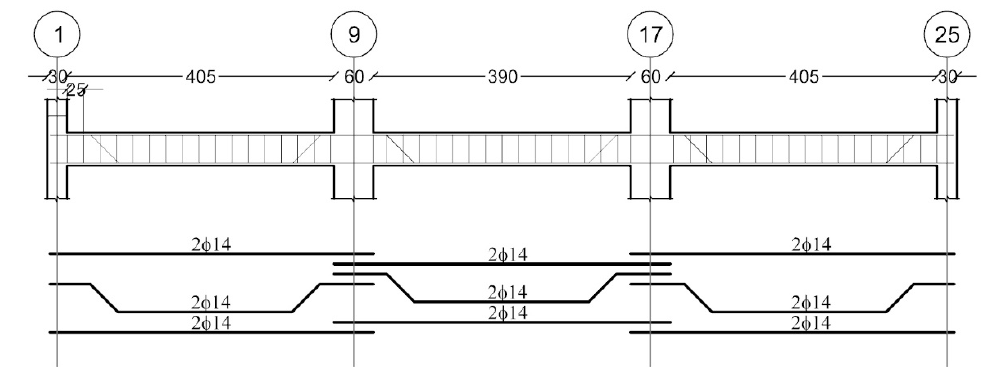
Figure 3. Example of reinforcement layout.